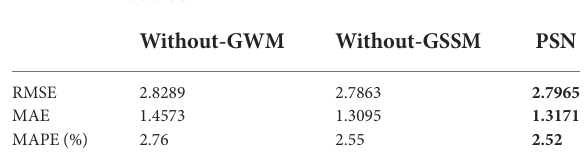
TABLE 5 PEMS04-30 min.